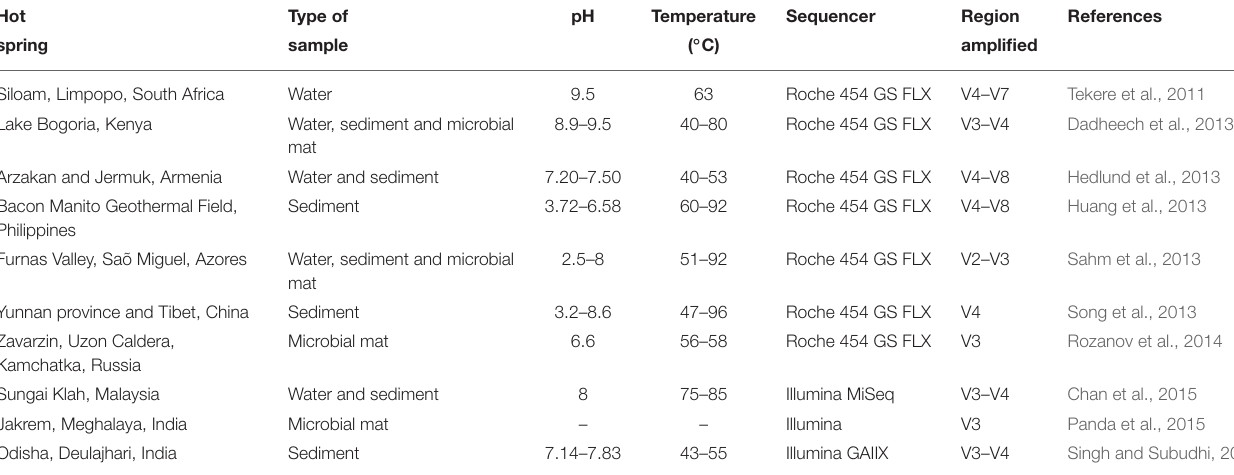
TABLE 1 | Examples of hot springs studied using the amplification of the variable regions of 16S rRNA. Hot Type of pH Temperature Sequencer